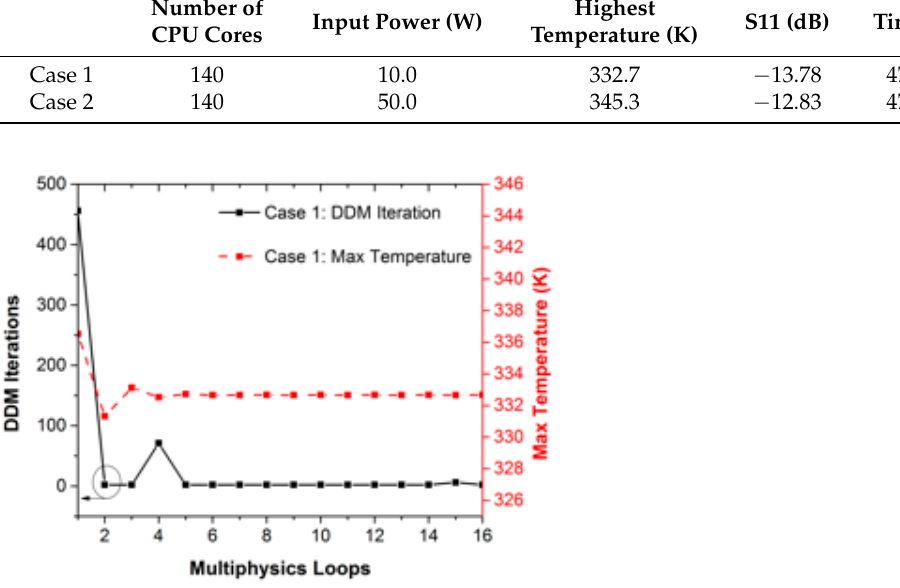
Figure 5. DDM iteration step change and maximum temperature change during multiphysics simulation of case 1.